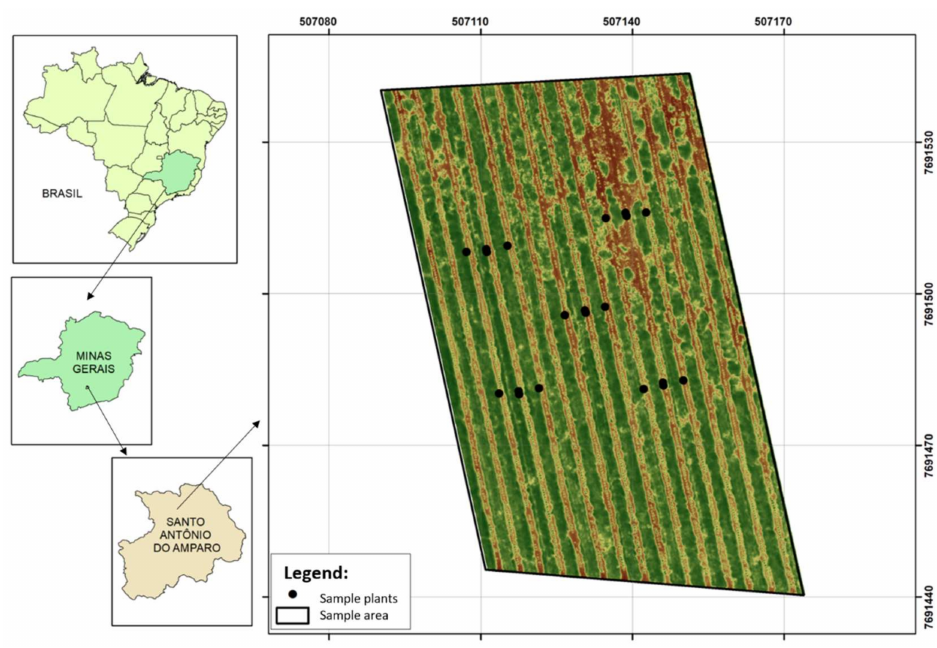
Figure 1. Location